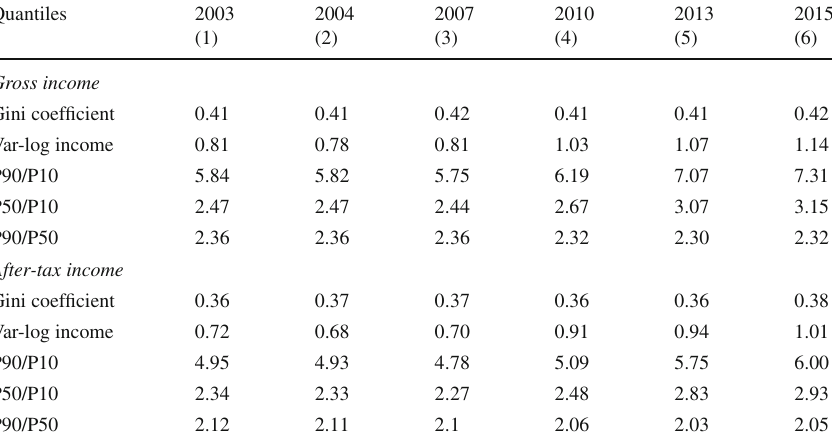
Table 15 Evolution of gross and after-tax income inequality indices in tax returns